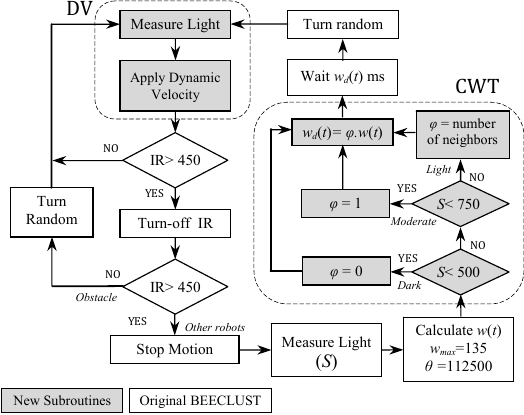
Fig. 14. Proposed aggregation algorithm based on combination between performed modifications